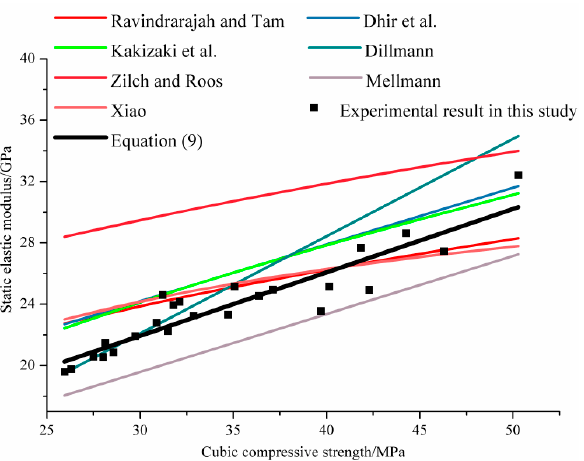
Figure 8. The static elastic modulus versus the cubic compressive strength of RAC.